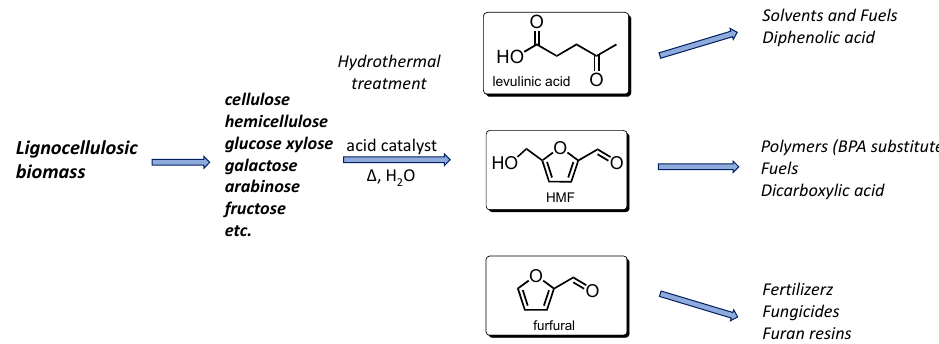
Scheme 1. Industrial importance of furfural, HMF, and levulinic acid.